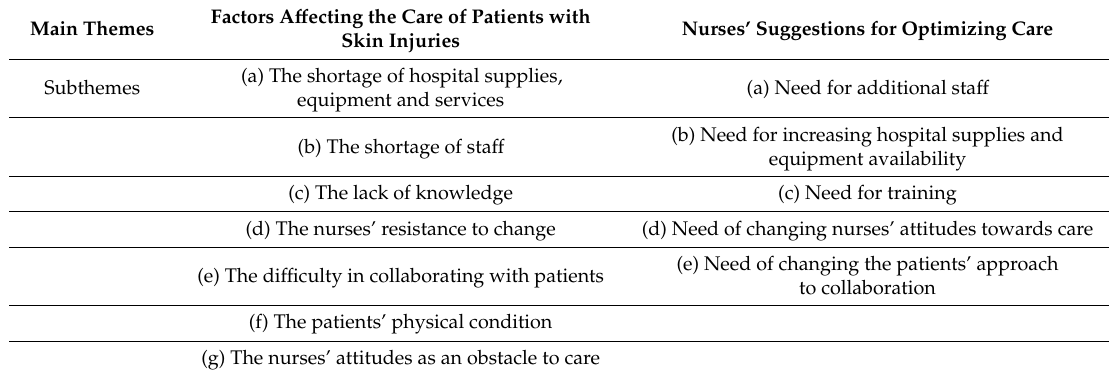
Table 2. Main themes and